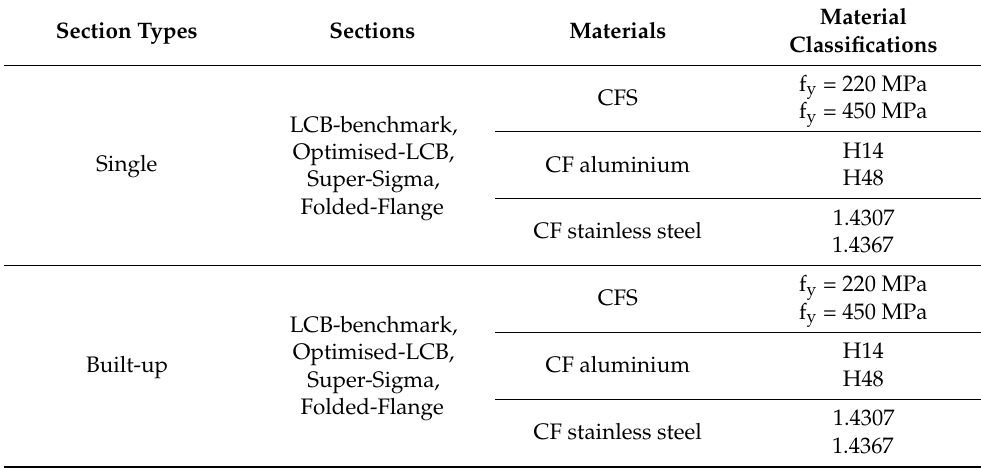
Table 4. Parametric plan of numerical investigation.